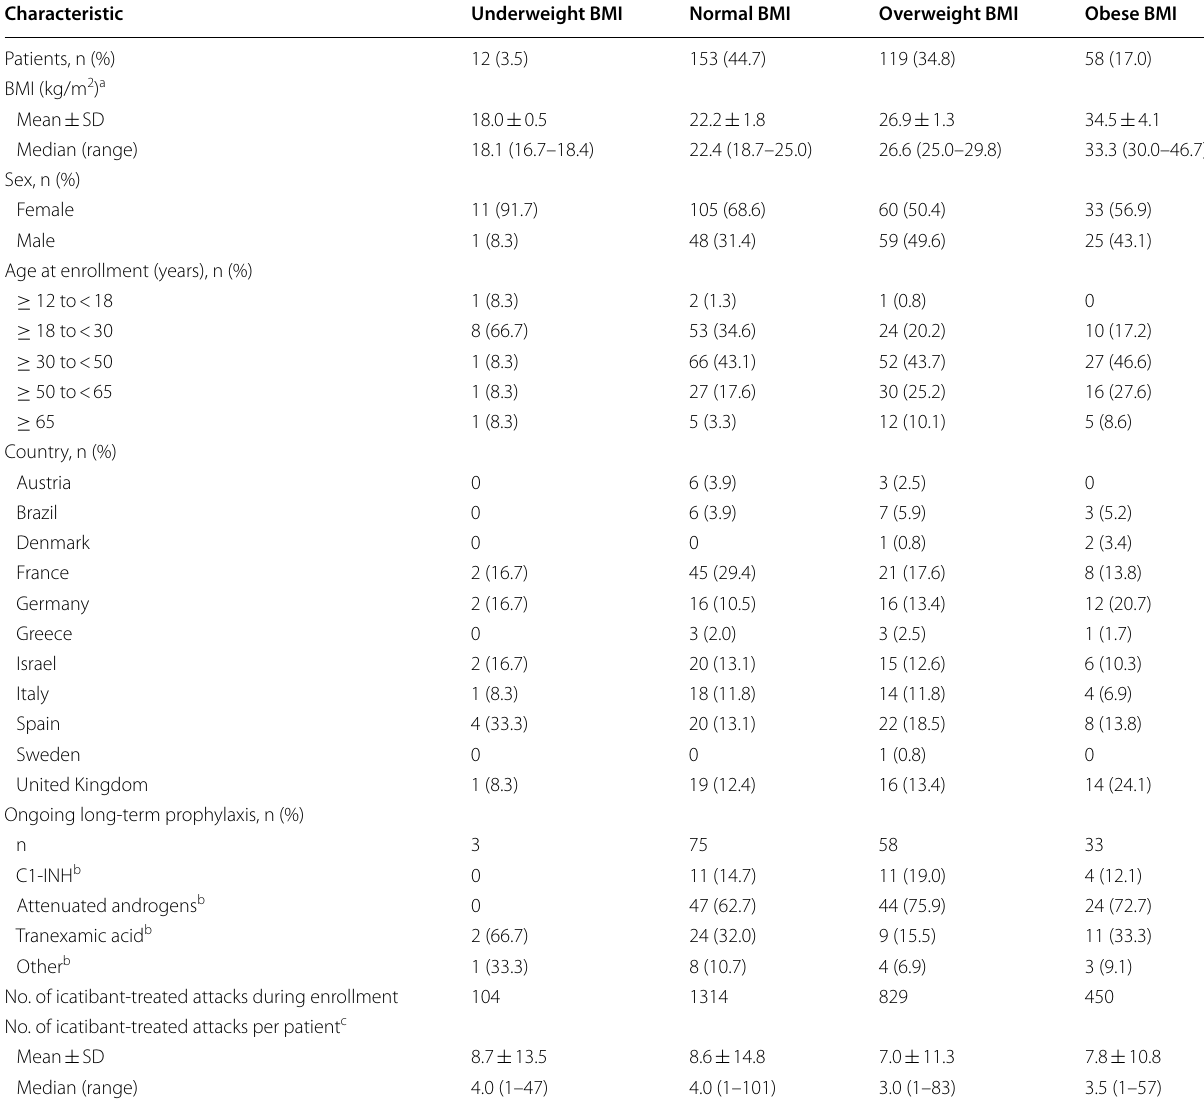
Table 1 Patient demographics and number of icatibant-treated